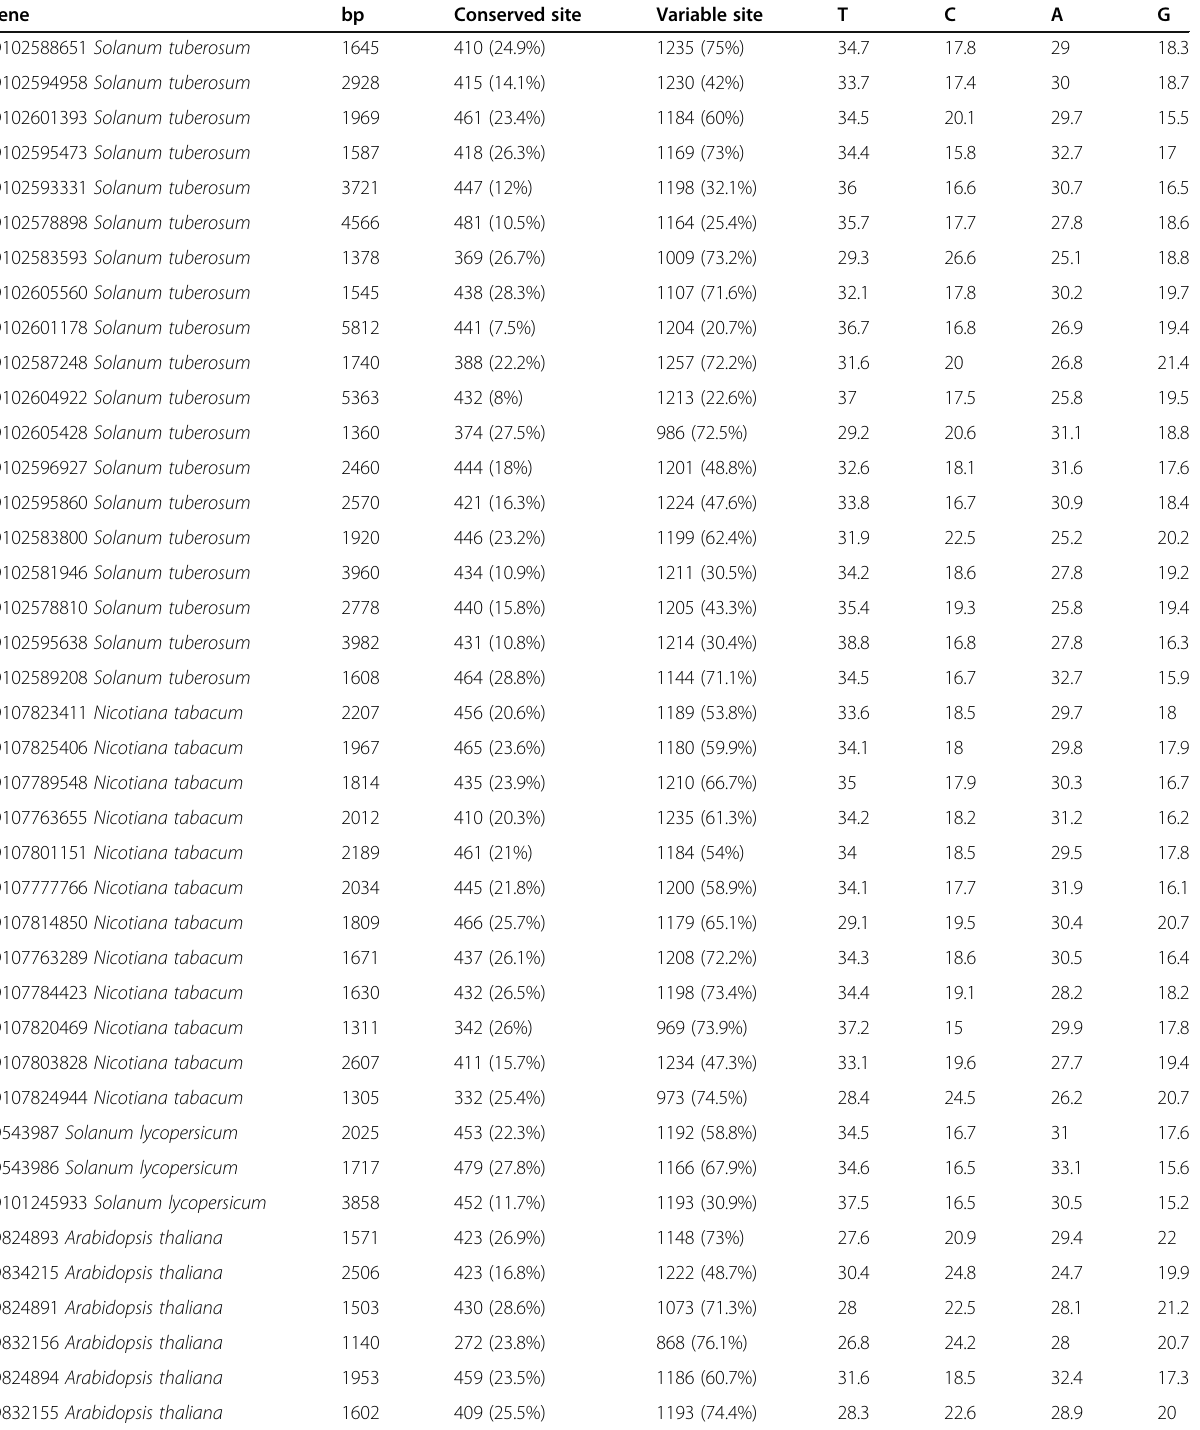
Table 7 Number of conserved sites, variable sites, and frequency of each nucleotide Gene bp Conserved site Variable site